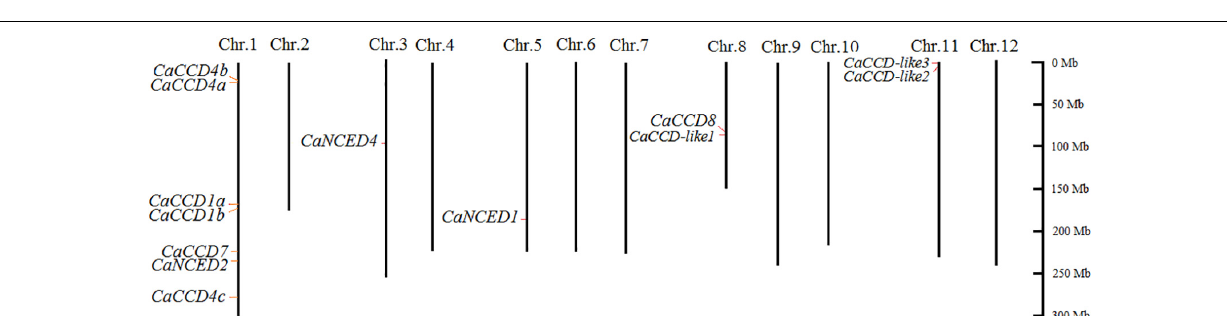
FIGURE 2 | Chromosomal mapping of the CCO genes in Capsicum annuum . The chromosome number is shown at the top of each bar chart, while the size of the chromosome is shown in its relative length. The scale on the right is in MB, and the short line represents the approximate positions of the CaCCO genes on the respective